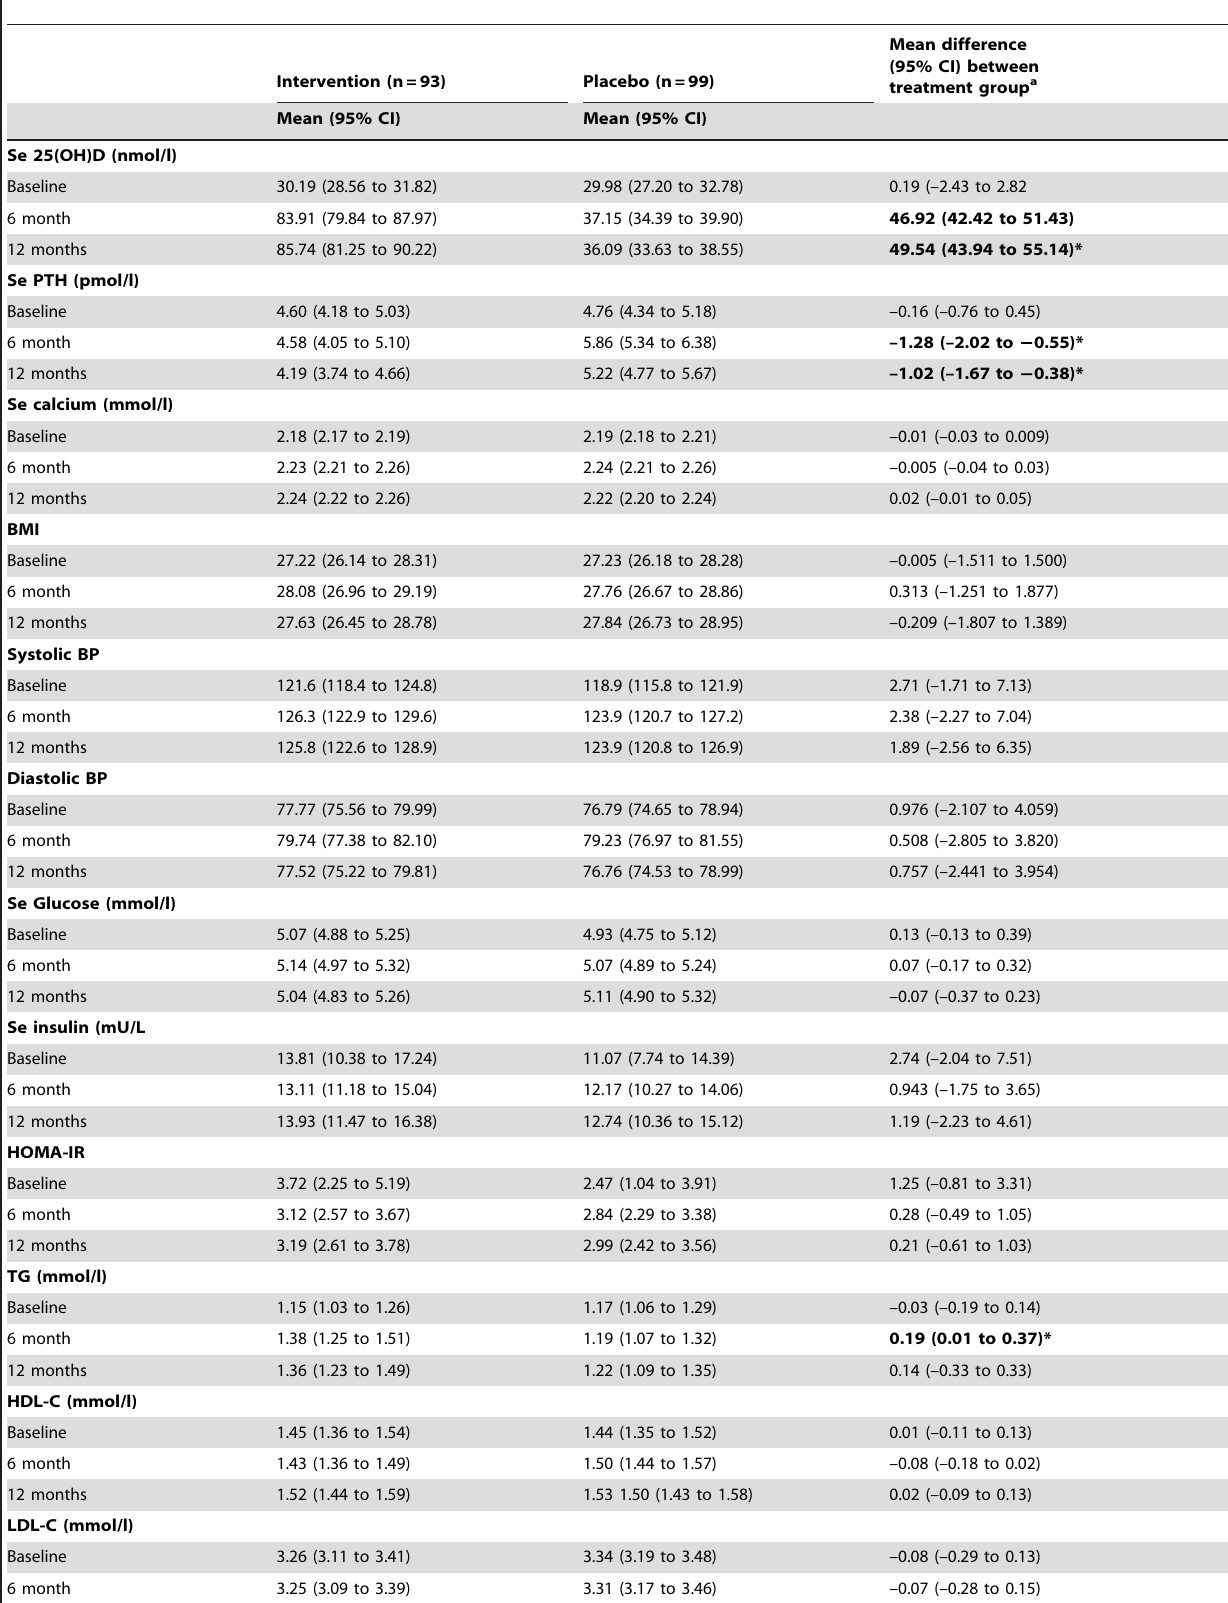
Table 2. Summary of the outcome measurements overtime (baseline, 6 months and 12 months) – Intention-to-treat